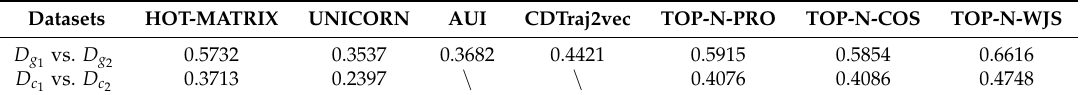
Table 4. Comparison of results of different methods on two